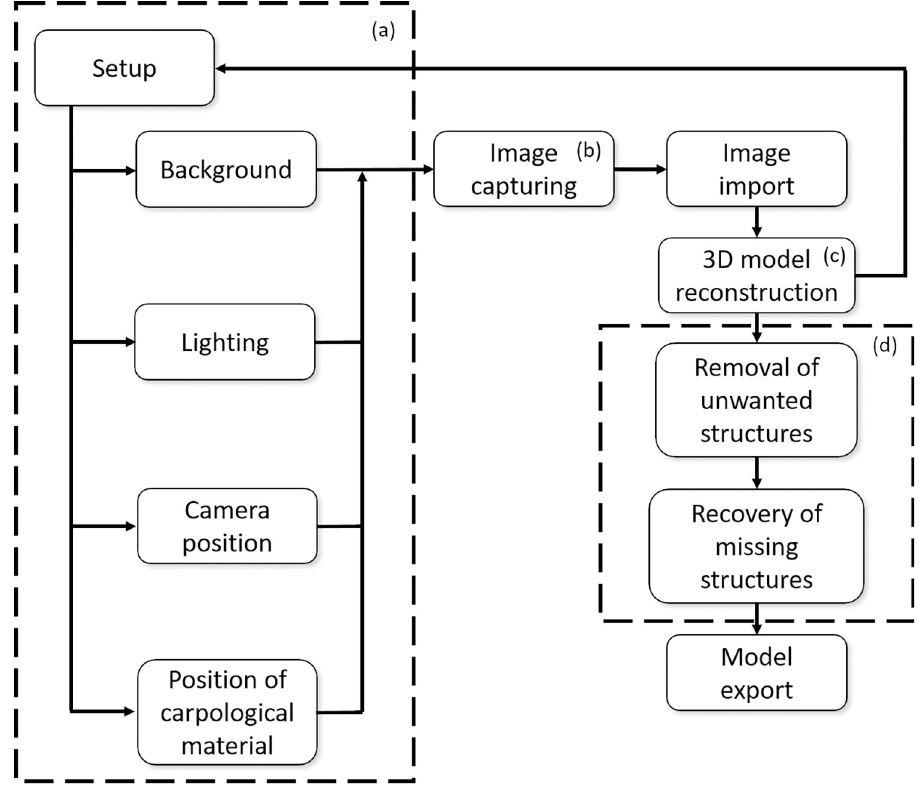
Fig 4. A workflow for 3D digitization of carpological material. (a) The set-up of the image capturing system includes background color, lighting, camera position and the position of the carpological material. The adjustment of these parameters depends on the morphology of the carpological material. (b) Image capturing process of each material usually lasts for 5 to 10 minutes. (c) The images are imported to the software for 3D model